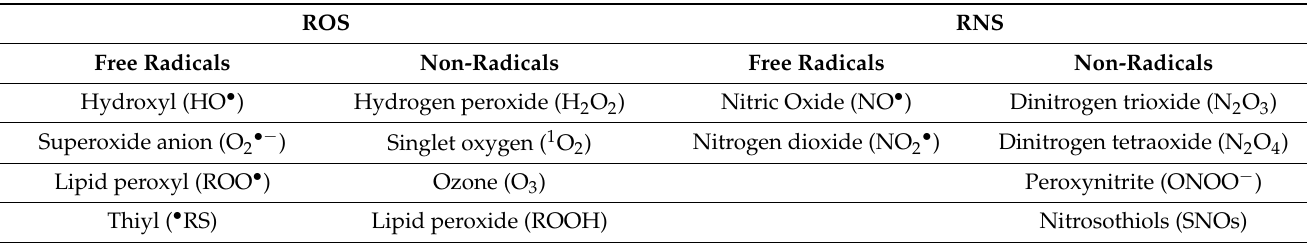
Table 1. Main radical and non-radical reactive oxygen and nitrogen species (ROS and RNS, respectively). ROS